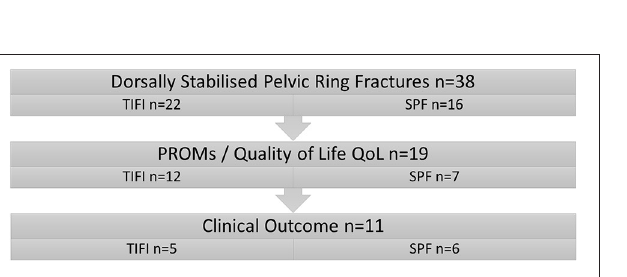
FIGURE 3 | Patient cohort. Patients were separated into two groups according to the surgical